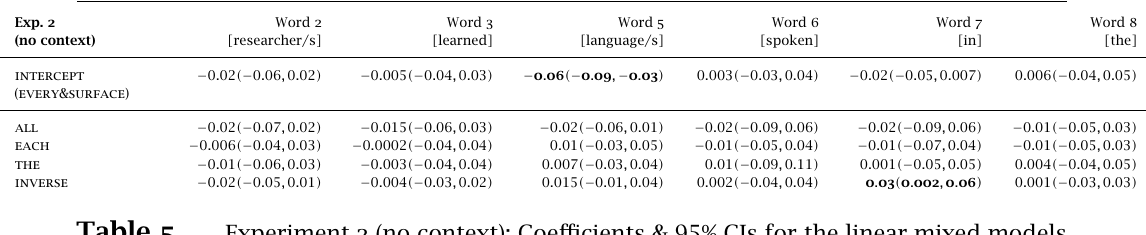
Experiment 2 (no context): Coefficients & 95 % CIs for the linear mixed models of the 6